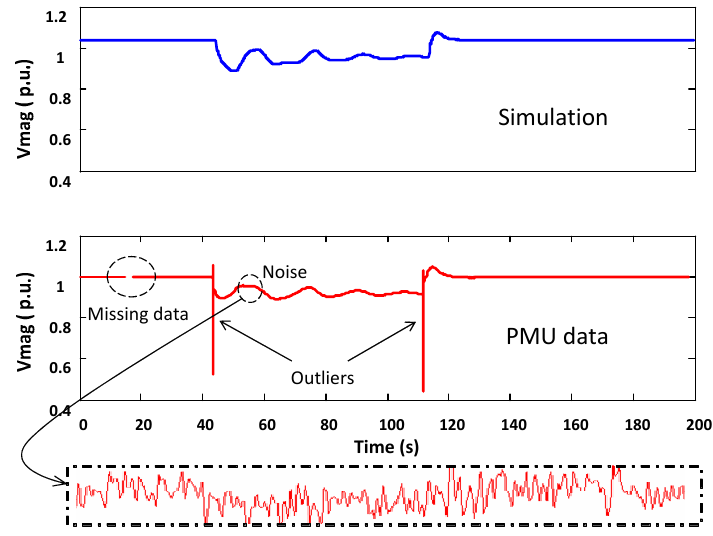
Figure 6. Difference between voltage responses from simulation and an actual PMU for the same disturbance.